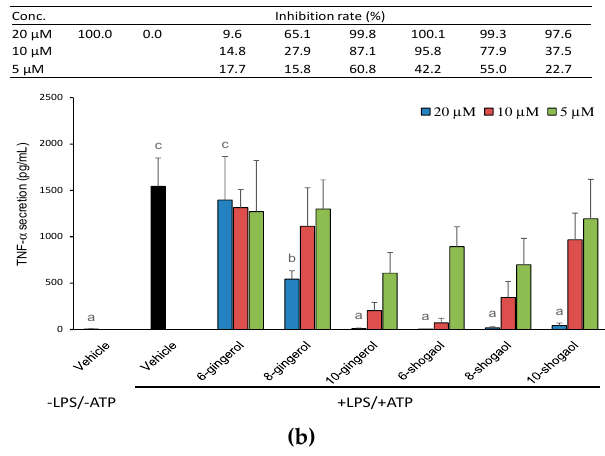
Figure 2. Effect of ginger phytochemicals on the LPS-primed and ATP-activated IL-1 β ( a ) and TNF- α ( b ) secretion in THP-1 macrophages. The phorbol 12-myristate 13-acetate (PMA)-differentiated THP-1 macrophages were treated with ginger phytochemicals for 1 h. Then, the cells were primed with LPS for 4h and activated with 5 mM ATP for 3 h. The medium IL-1 β and TNF- α concentration was assessed by an enzyme-linked immunosorbent assay (ELISA) kit. Data are expressed as the mean ± SD of triplicate independent experiments. Values of the ginger phytochemicals at concentration of 20 µ M with different superscript letters are significant different from one another ( p < 0.05).